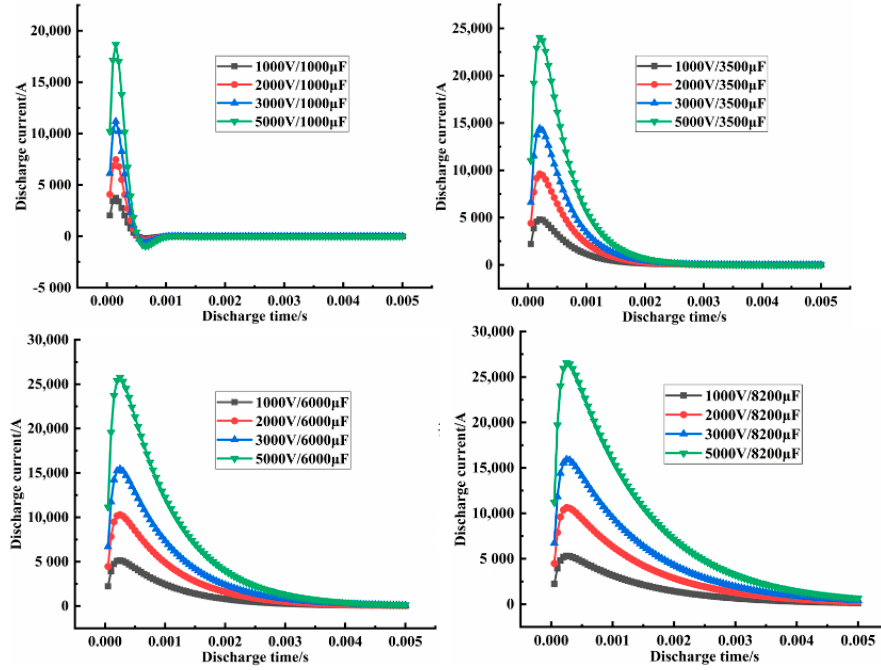
Figure 10. The different voltage influence on discharge current.